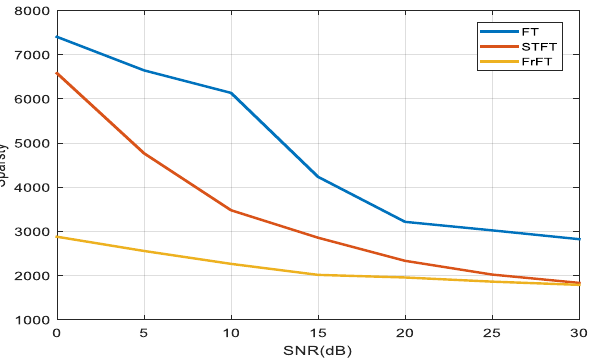
Figure 11. Sparsity comparison of different SNR after different transformations (50 times).